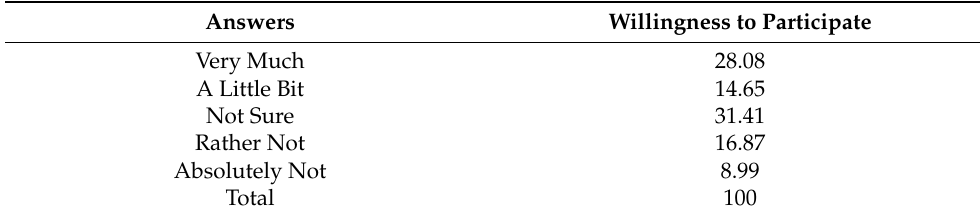
Table 1. Frequency distribution of the dependent variables (%).